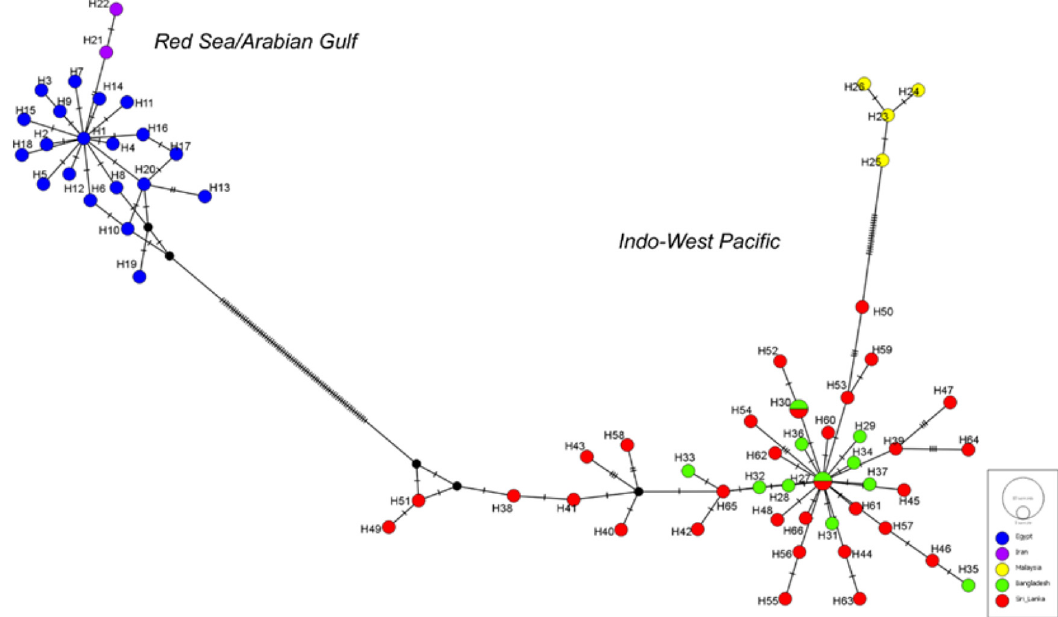
Fig. 5. Median-joining haplotype network for COI sequences in P. semisulcatus from the Red Sea, the Arabian Gulf, and the Indo-West Paci fi c region (Bangladesh, Sri Lanka, Malaysia). The colour legend is shown on the down-right side of the graphic. Table 3. Analysis of molecular variance (AMOVA) of F st values for grouped P. semisulcatus COI sequences from different sampling locations in the NW of the Red Sea. Among groups Among-populations, within-groups Within